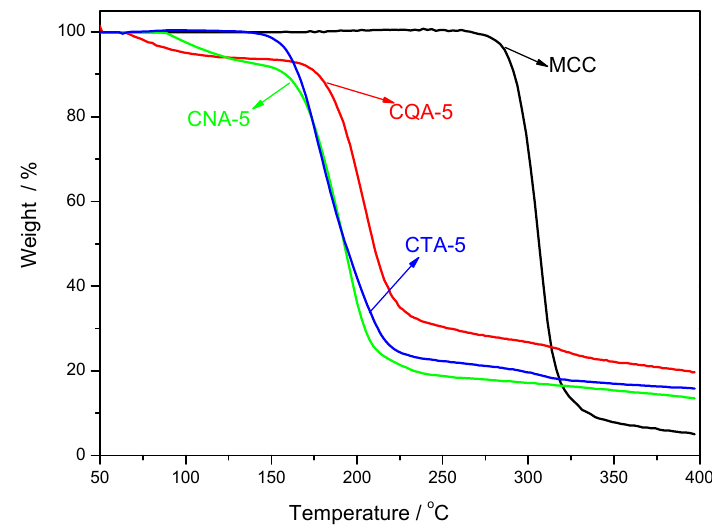
Figure 4. Thermal decomposition profiles of the original cellulose and regenerated cellulose materials. Samples were heated in platinum container under an air atmosphere at 5 °C/min.